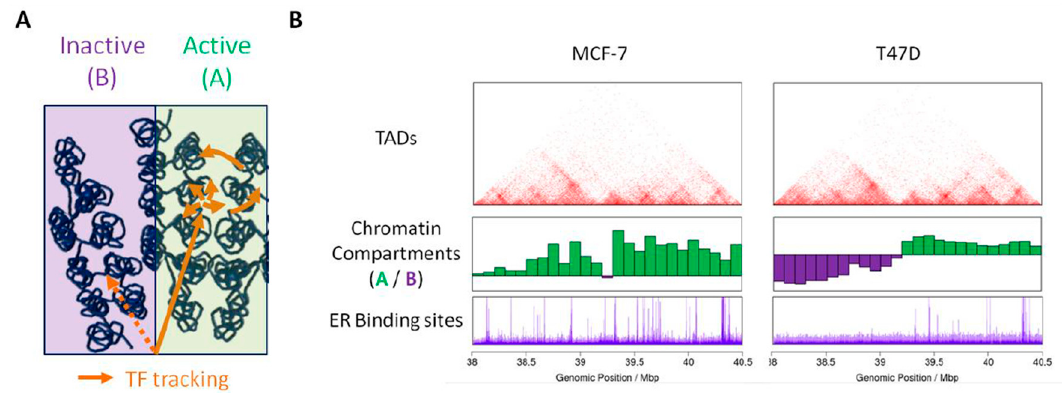
Figure 2. 3D genome folding modulates the binding of steroid receptors. ( A ) Active and inactive chromatin compartments can favor or limit, respectively, the diffusion of transcription factors within the nuclear space. Long-range folding of the chromatin fiber can facilitate the tracking and permit local enrichment of factors in given nuclear environments. ( B ) In contrast to the conservation of borders between TADs (top panel—frequencies of contacts in red), chromosomal domains belong to the A (green) or B (purple) compartment in a cell specific manner (middle panel). These differences correlate with the extent of binding of the ER as shown by ChIP-Seq experiments in MCF-7 and T47D (bottom panel).